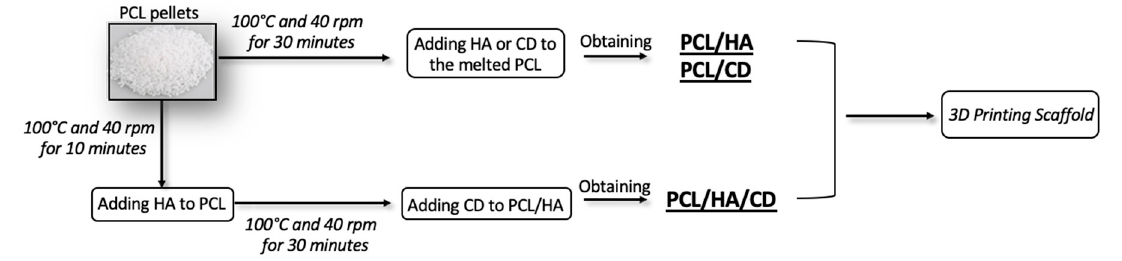
Figure 1. A flow diagram lustrating the mixing process for the generation of PCL, PCL/HA, PCL/CD and PCL/HA/CD blends.